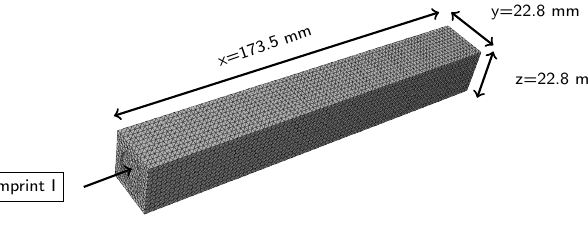
Figure 3. Meshed specimen for FEM calculation of natural frequencies and eigenmodes.